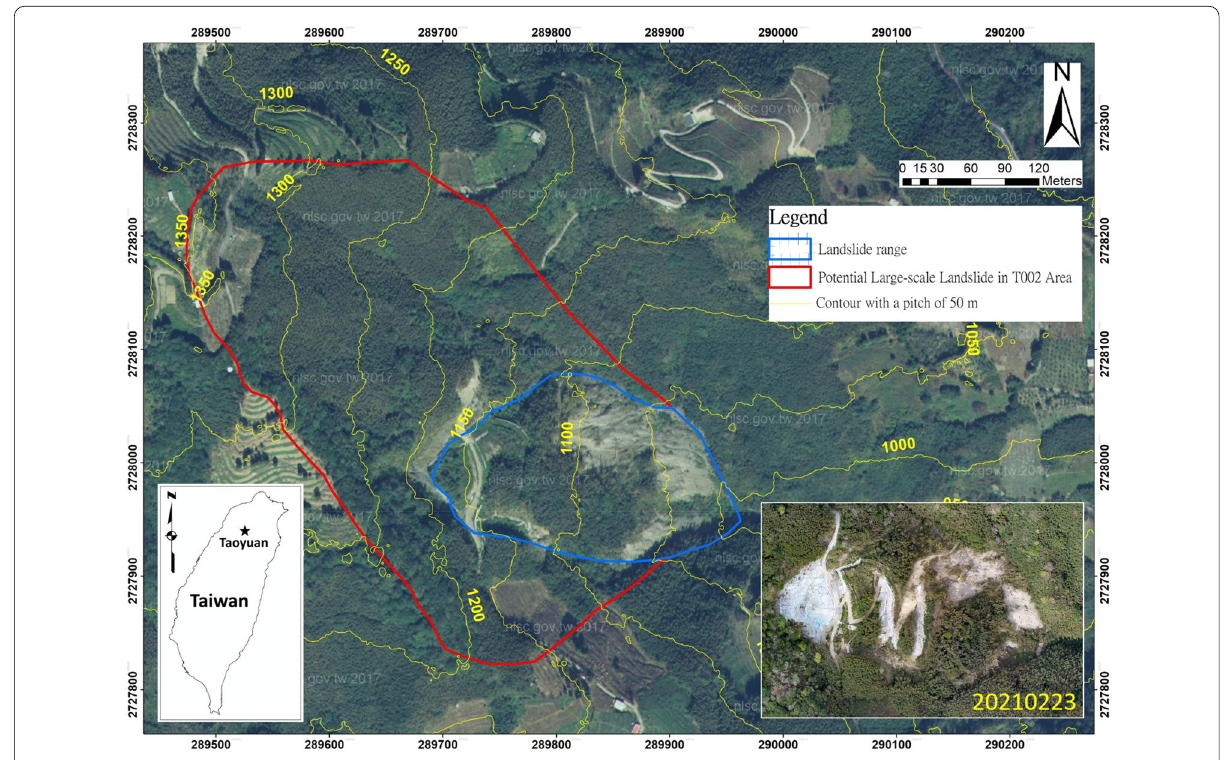
Fig. 1 Location maps of the study